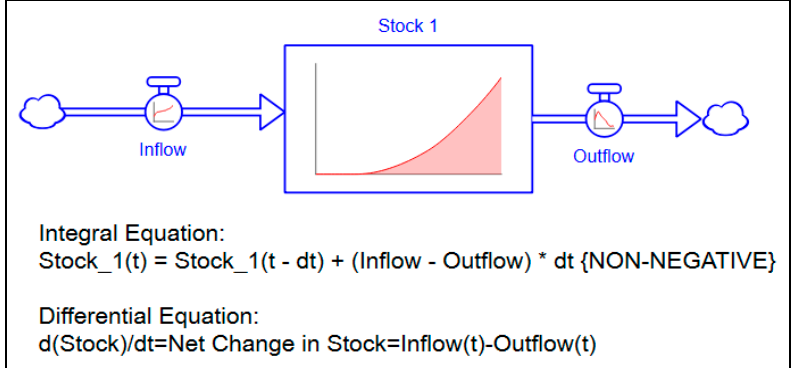
Figure 4. General stock and flow structure.